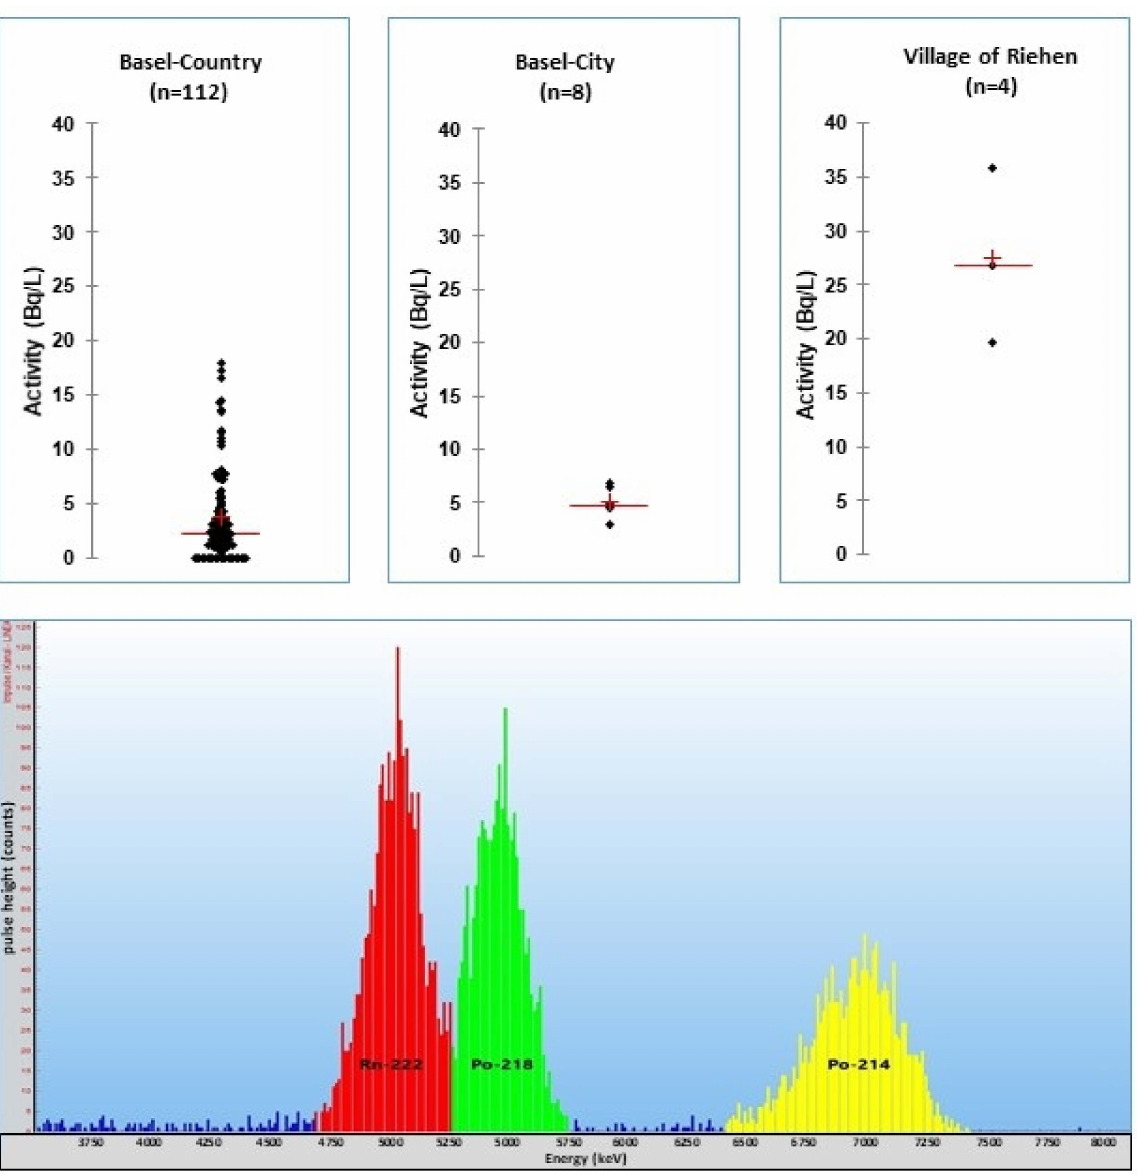
Figure 6. Scatter diagrams of radon activity concentrations in 124 tap water samples of all villages in Basel–Country, Basel–City and the village of Riehen [45]. Spectrum below: RADONS extract of a ground water sample (village Riehen, 5 Bq/L 222